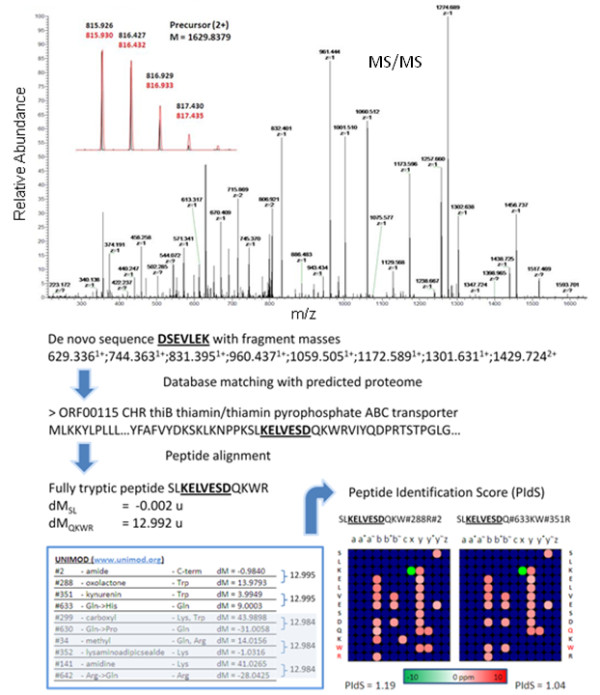
Post-translational chemical medication (PTCM) analysis using de novo-Ustag approach. An example illustrating the application of de novo-UStag approach in detection of multiple modification and high resolution MS/MS for distinction between multiple possible combinations. C-terminus amidation and tryptophan oxidation to oxolactone was determined for the sequence SLKELVESDQKWR of the Salmonella thiamin/thiamin pyrophosphate ABC transporter protein. Explanation for the determination of modifications is detailed in text.